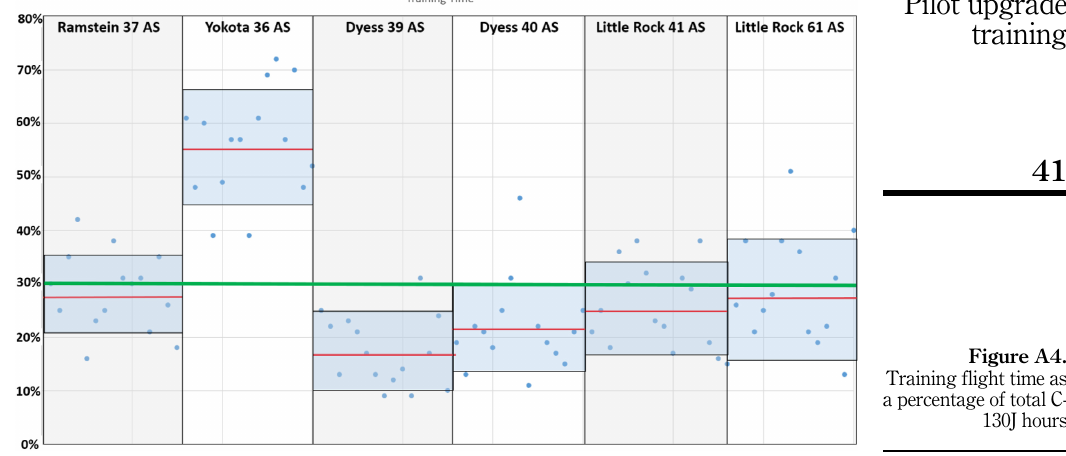
Figure A4. Training flight time as